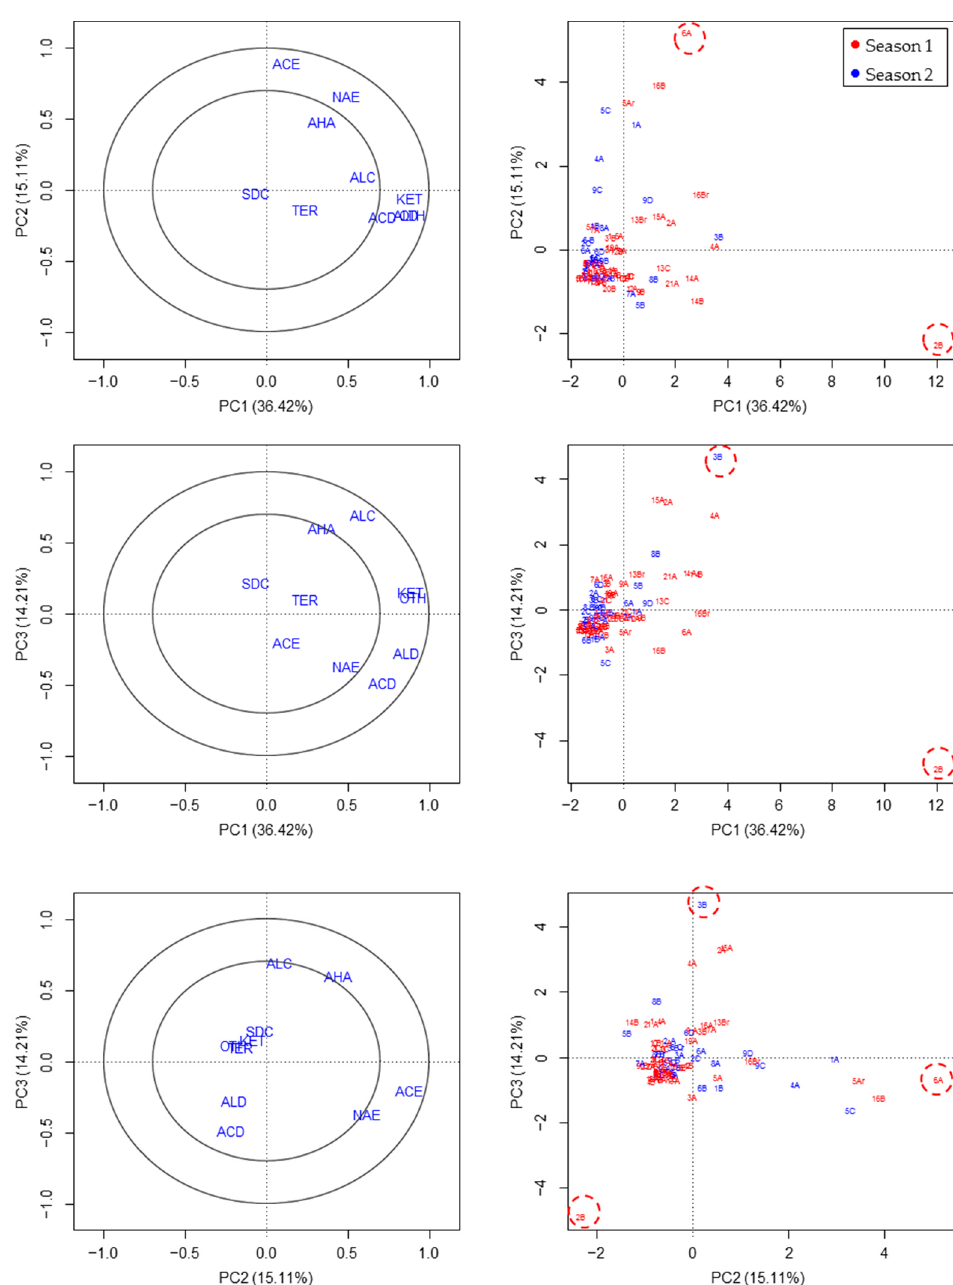
Figure 1. Correlation ( left ) and score ( right ) plots of the first three components of the PCA (with 67.82% of variance explained) applied to compound classes of aroma variable based on total areas (only compounds with match quality >50 without exogenous compounds), obtained in two seasons. The areas of compound classes were normalized to the response of the internal standard (1-phenylethanol) for each season. ACE, acetate ester; NAE, non-acetate ester; ALD, aldehyde; ALC, alcohols, KET, ketones; SDC, sulfur derived-compounds; TER, terpenes; AHA, alkanes and aliphatic compounds; OTH, other compounds. Circles represent r 2 = 50% and 100% variability explained by the components. Potential outliers are marked by dashed red line.